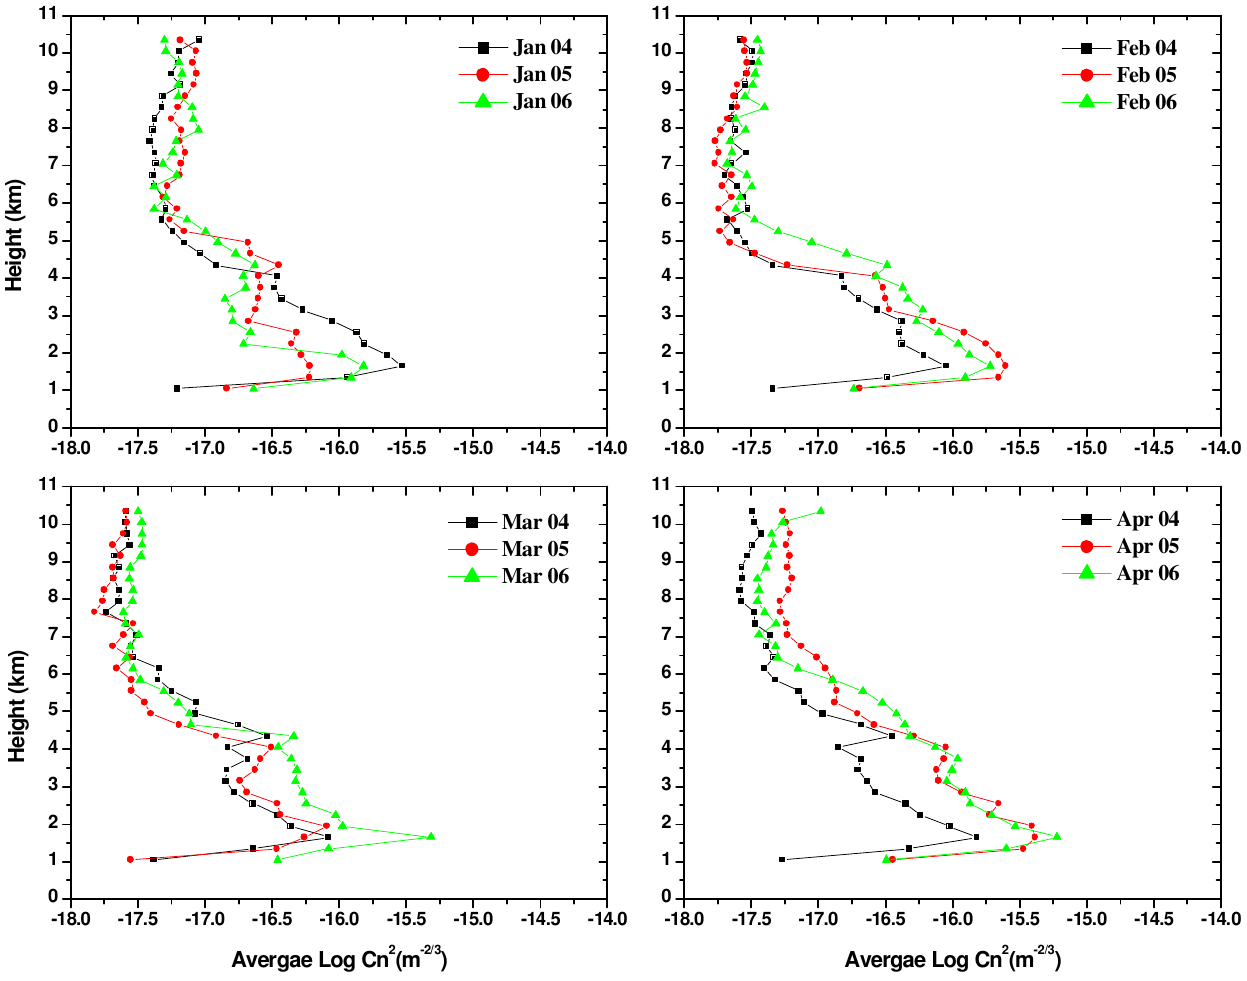
Fig. 9. Height profile of mean Log C 2 n showing inter-annual features for the months of January, February, March and